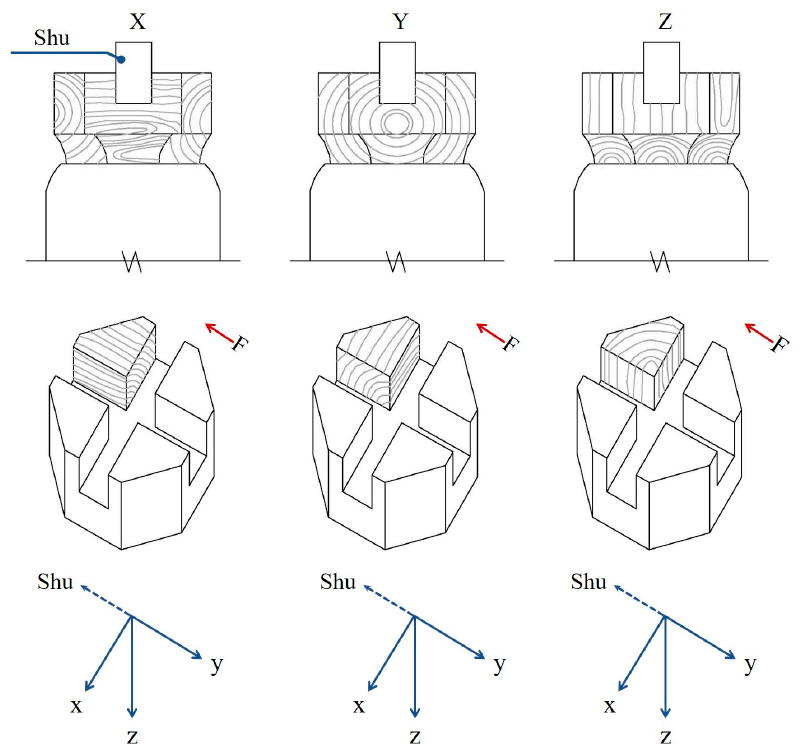
Figure 7. Directions of wooden fibre of Zuo-Dou connection. Table 1. Associated materials in the rotational and shear tests.